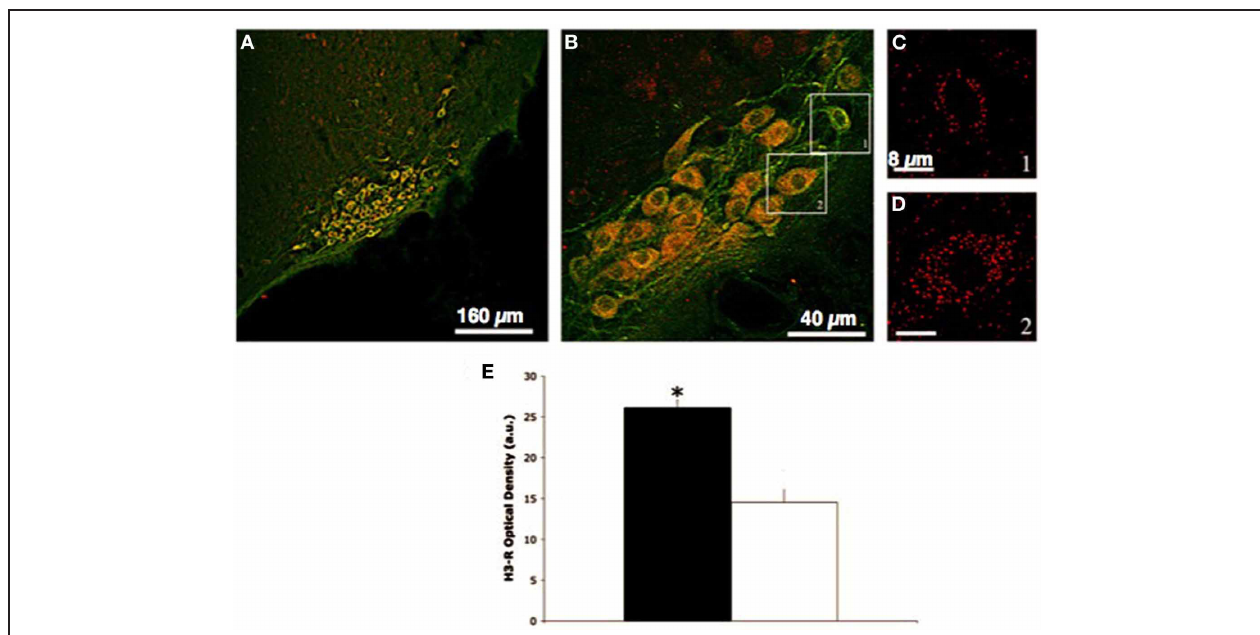
FIGURE 1 | Distribution of H 3 -R on TMN histaminergic neurons. (A,B) HDC-positive cells in the E2–E3subdivision of the TMN showing H 3 -R fluorescence; (C,D) high resolution z-projections of H 3 -R expression in the HDC-positive neurons selected in (B) ; (E) Average intensity of colocalised signals. Analysis of immunocolocalization density was carried out on regions of interest (ROI) of identical area (576 pixels), identified on randomly chosen